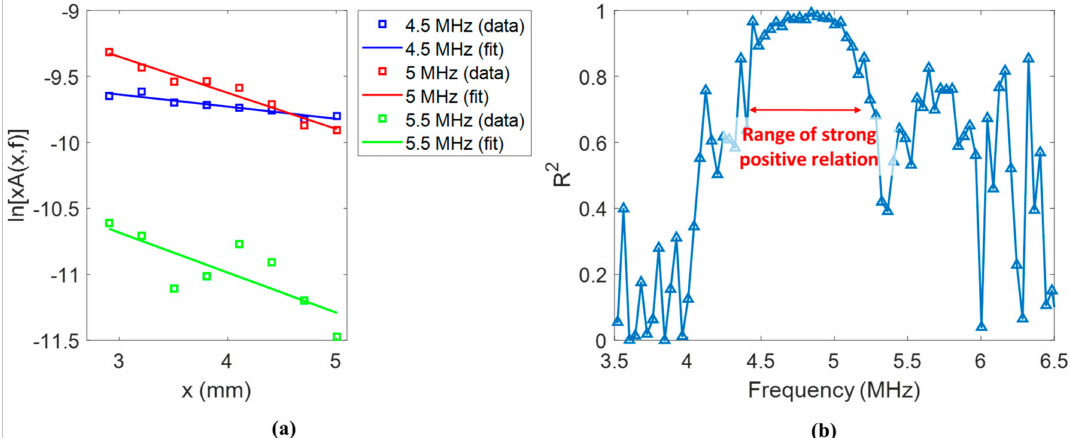
Figure 7. Example of linear regression using the assumed model: ( a ) least-squares fit, and ( b ) coefficient of determination.